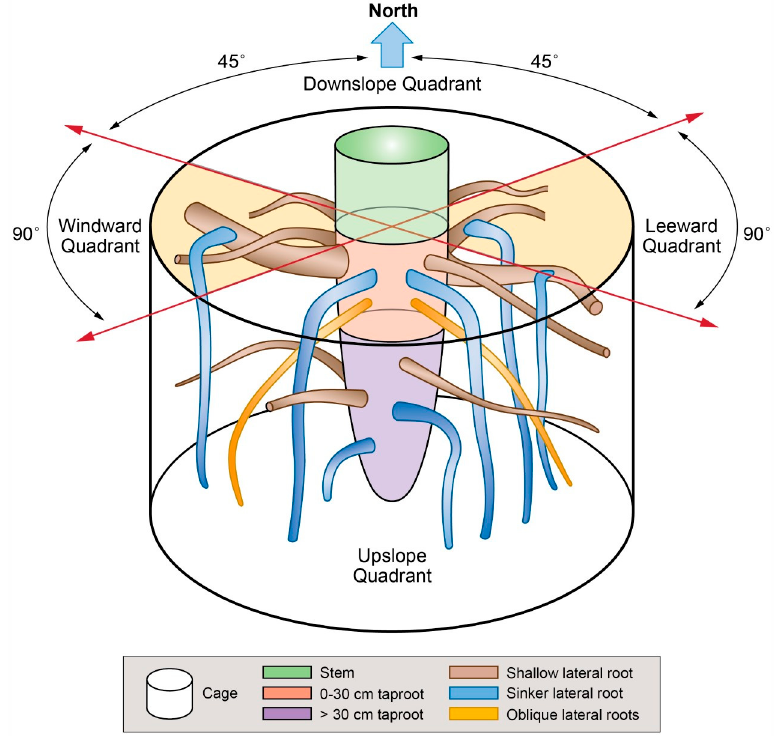
Figure 1. Schematic representation of the root cage and root types at two soil depths.